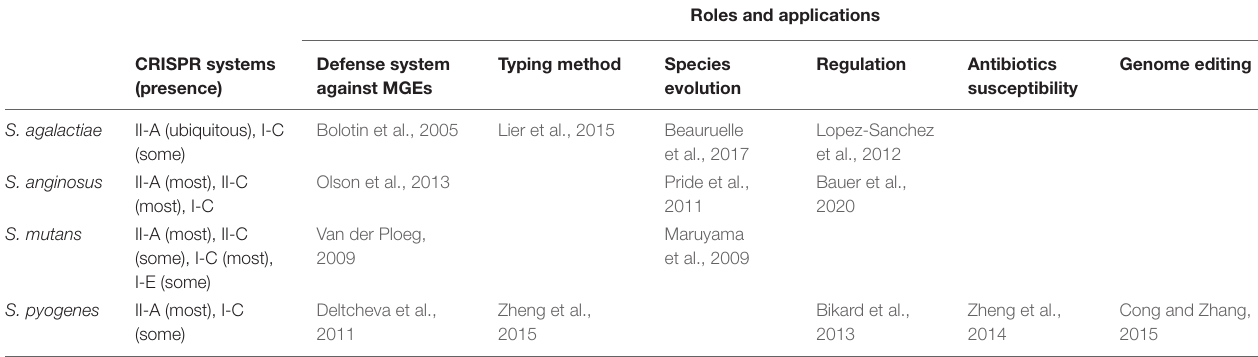
TABLE 2 | Roles and applications derived from CRISPR-Cas systems of pathogenic streptococci, described in